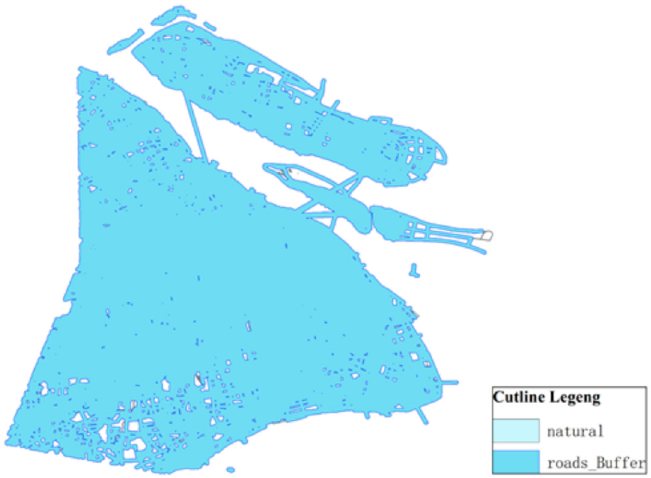
Figure 6. Traffic artery buffer zone.